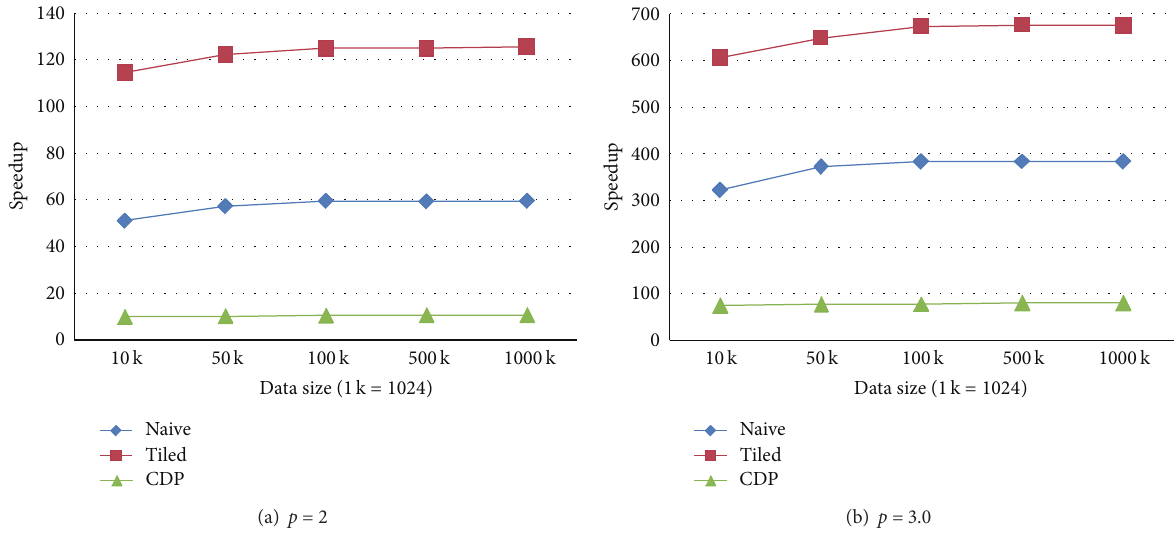
Figure 3: Speedups in the test case when the numbers of prediction points and data points are identical. (a) The form in which the power parameter is set to 2. (b) The form in which the power parameter is set to 3.0.